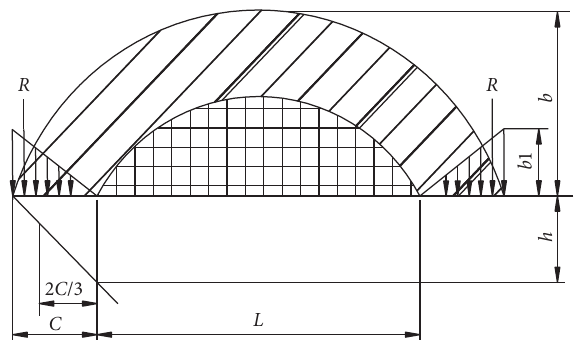
Figure 1: The map of roof caving